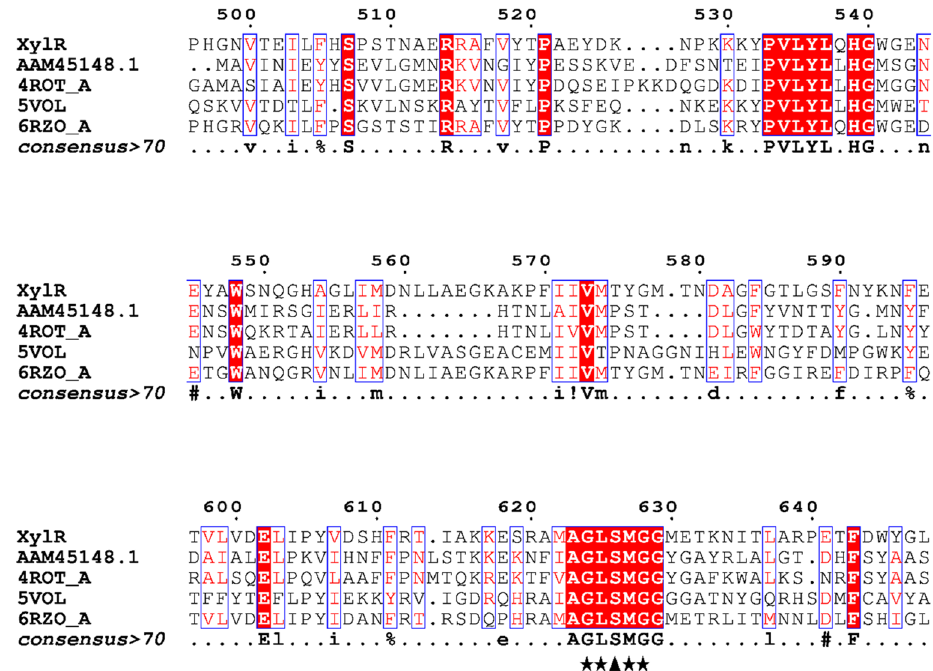
Figure 2. Fragment of the multiple alignment between the XylR amino acid sequence and CE1 family esterases. The conserved regions are marked with , and the conserved catalytic residue of serine (S) is highlighted with ▲ . The alignment includes the esterase sequences of Lactococcus lactis (AAM45148), Bacteroides intestinalis ★ DSM 17,393 (5 VOL), Streptococcus pyogenes (4ROT) and a noncultivable bacterium (6RZO). Similar amino acids are highlighted in red. Multiple alignments were performed using, the Clustal Omega tool 16 and assembly was performed in EsPript 3.0 17 .